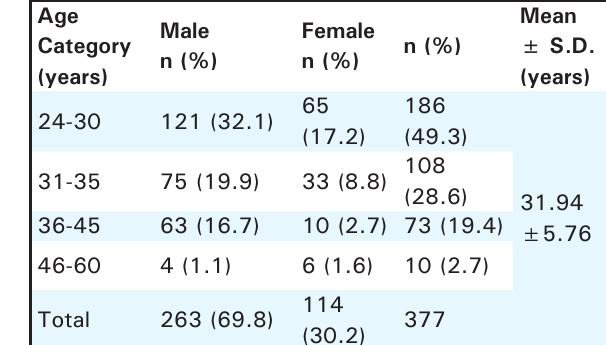
Table 2. Age categories of medical